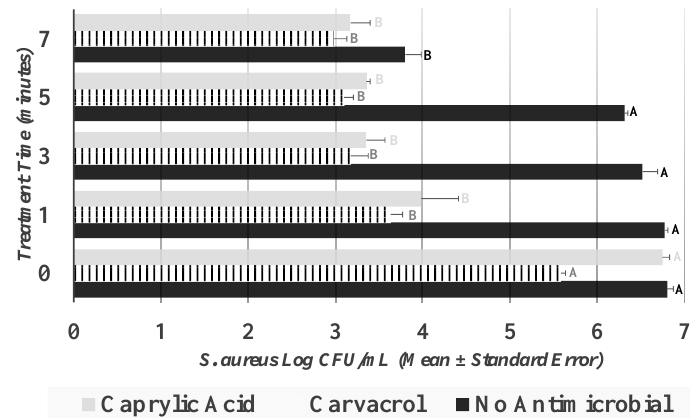
Figure 5. Inactivation of S. aureus by elevated hydrostatic pressure in presence of 0.5% ( v / v ) caprylic acid and carvacrol. Values followed by different upper-case letters are statistically ( p < 0.05) different than each other (pair-wise comparisons, Tukey-adjusted ANOVA). For control samples, those treated with caprylic acid, and those treated with carvacrol, statistical analyses are presented separately by upper-case letters with different colors.